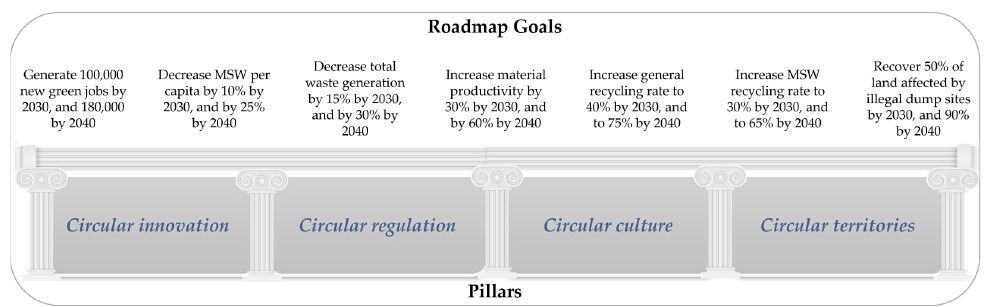
Figure 2. Roadmap for a Circular Chile by 2040.